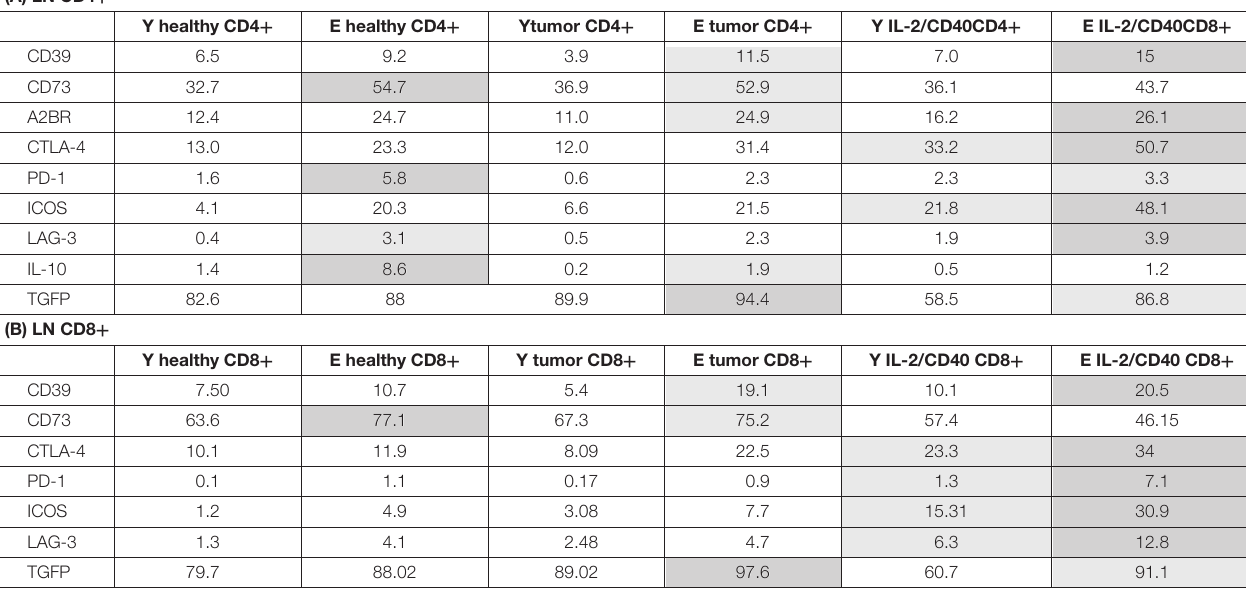
TABLE 2 | Changes to regulatory molecules on LN CD4 + (A) and LN CD8 + (B) T cells with age and IL-2/CD40. (A) LN CD4 + (A) LN CD4 + Y healthy CD4 + Y healthy CD4 + E healthy CD4